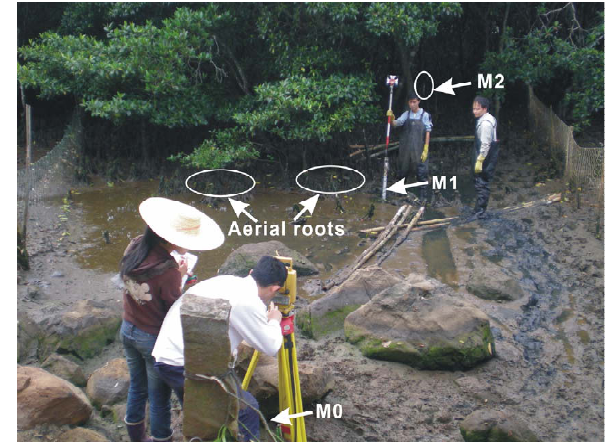
Fig. 5. Boulders (0.2–1.5m in diameter) exposed near the surface of M0 during low tides. Aerial roots, M1, and M2 are also shown.